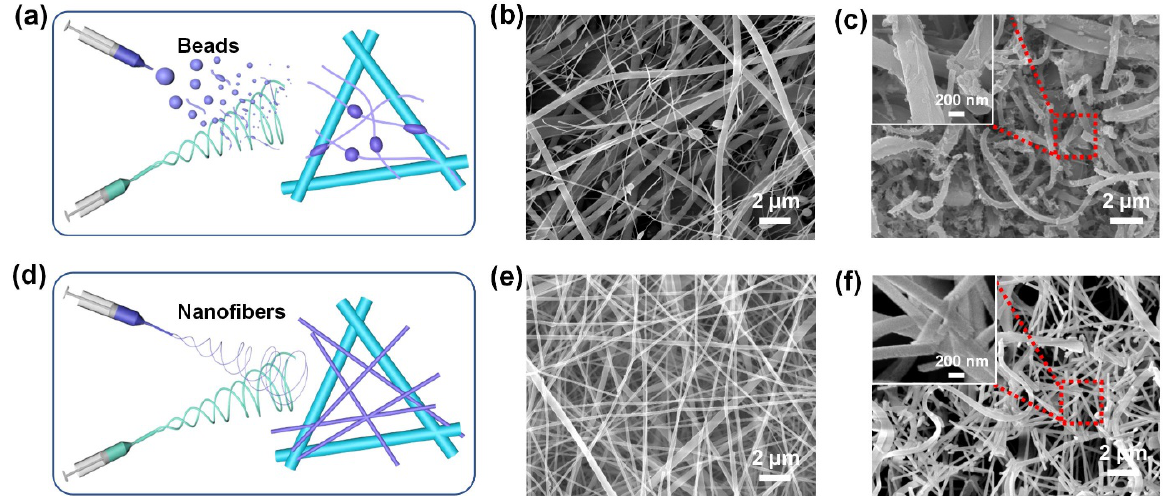
Fig. 2 Structural regulation of BiFeO 3 /SiO 2 fibrous membranes. (a) Schematic illustration of the forming of BiFeO 3 /SiO 2 bead/fiber. (b, c) SEM images of bead/nanofiber composites before and after calcination, respectively. (d) Schematic illustration of the forming of BiFeO 3 /SiO 2 dual-nanofiber structure. (e, f) SEM images of dual-nanofiber structure before and after calcination,